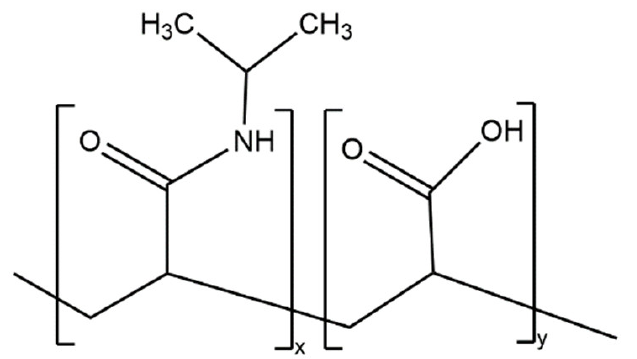
Figure 2. Chemical structure of poly(N-isopropylacrylamide-co-acrylic acid) (pNIPAM-AAc). This random copolymer has an LCST of 36 °C.